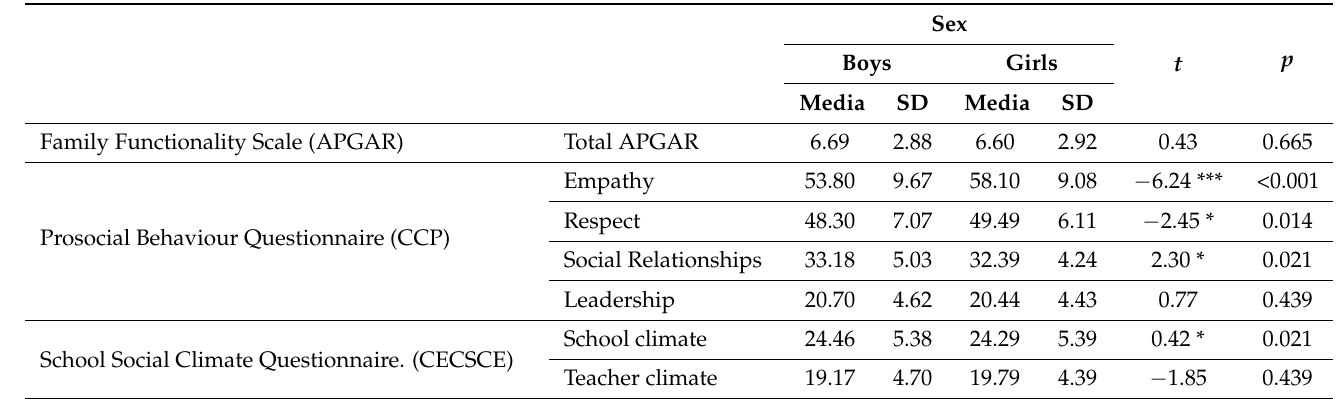
Table 2. T -test by sex (girls n = 377; boys n = 366).